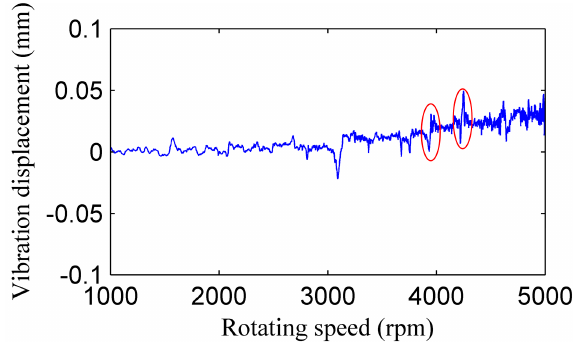
Figure 10. Vibration displacement of blade 1.